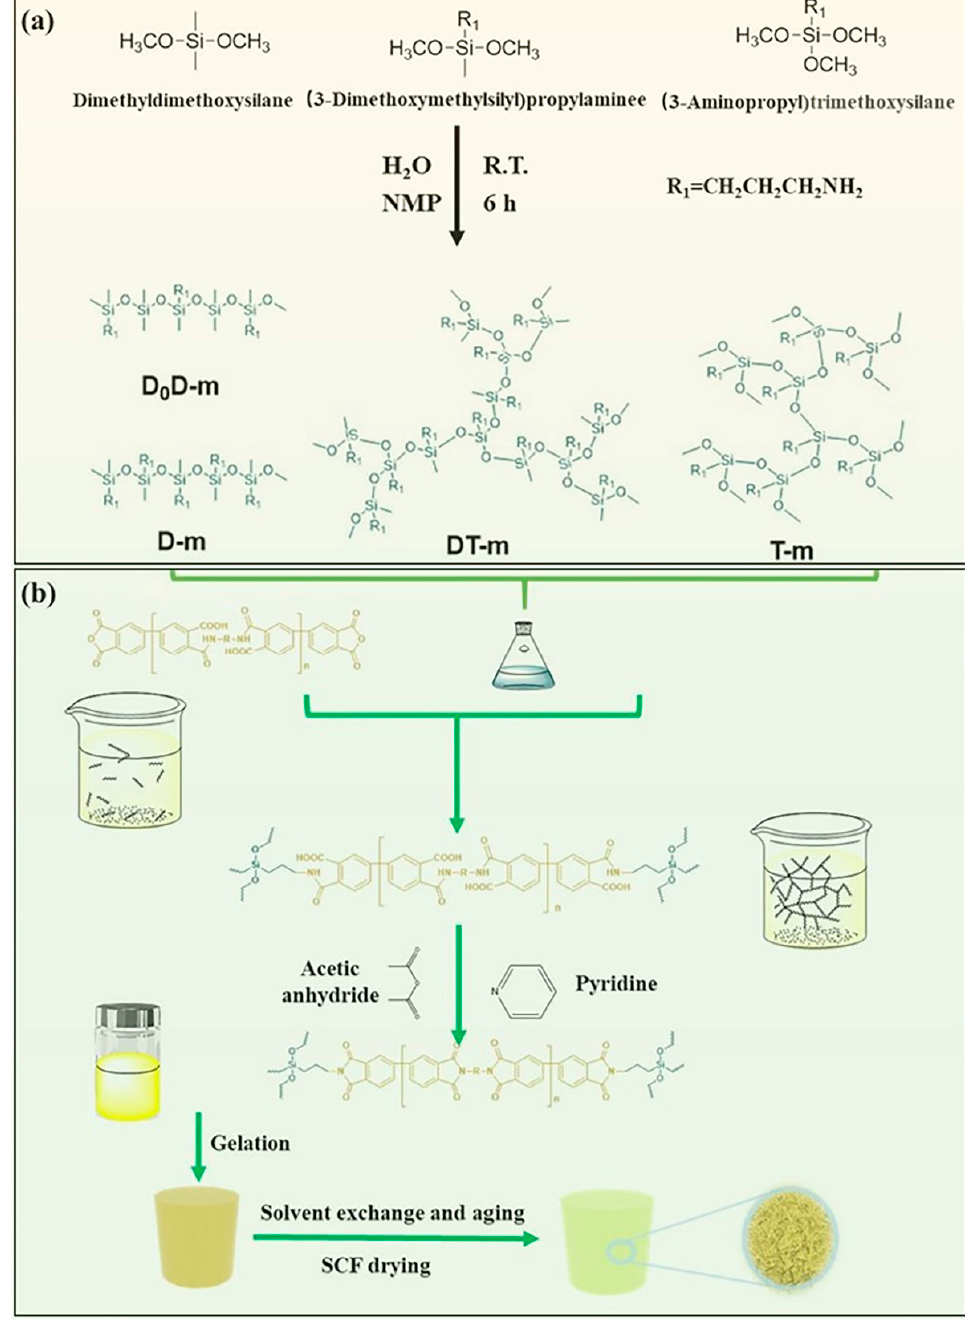
Figure 1. ( a ) Schematic diagram of the crosslinker preparation process; ( b ) Schematic diagram of the polyimide aerogel preparation